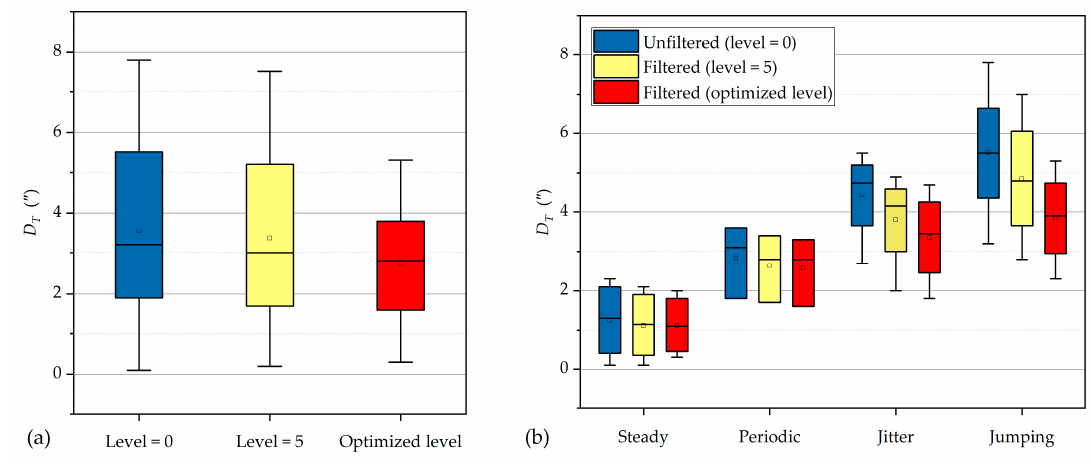
Figure 9. The boxplots of D T : ( a ) D T for di ff erent filtering schemes; ( b ) D T for each type of